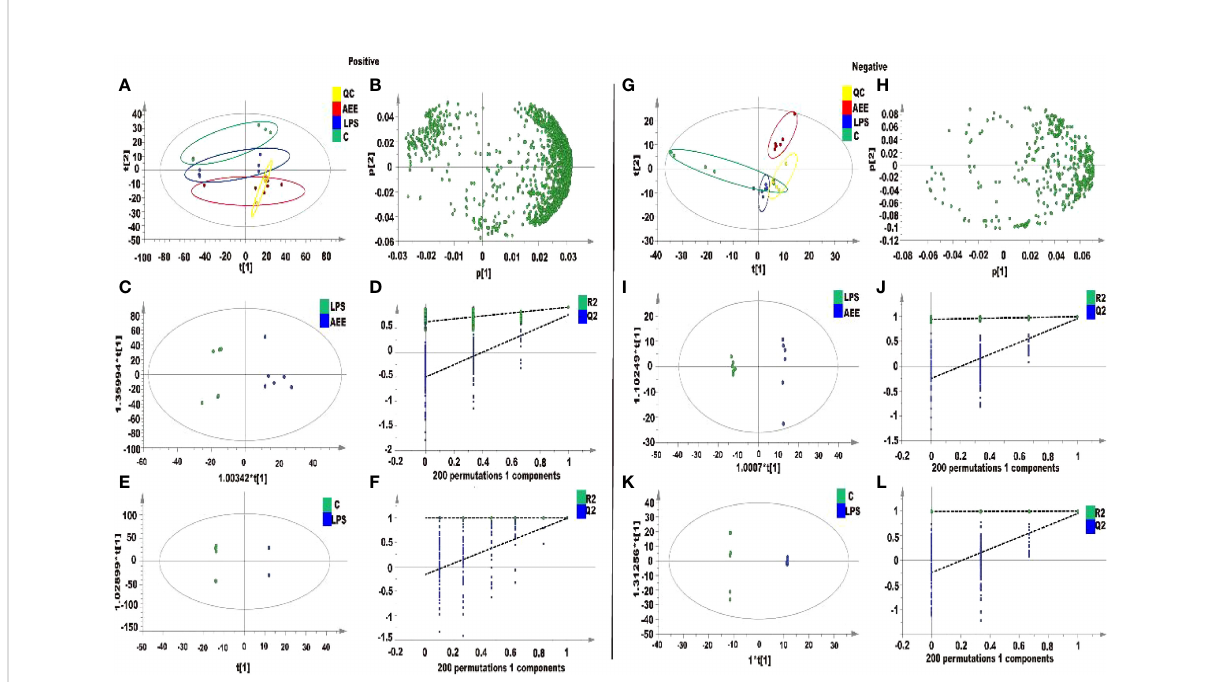
FIGURE 9 Metabolomic analysis of the effect of AEE on LPS-induced ALI in rats. (A, G) PCA score plots based on rat sera obtained from control, LPS and AEE groups in positive and negative modes, ESI+: R 2 = 0.878, ESI-: R 2 = 0.829. (B, H) The loading plots of AEE and LPS groups in positive and negative modes. (C, I) OPLS-DA score plots for AEE and LPS groups in positive and negative models, ESI+: R 2 X = 0.807, R 2 Y = 0.926, Q 2 = 0.768; ESI-: R 2 X = 0.646, R 2 Y = 0.998, Q 2 = 0.958. (D, J) Permutation test for the OPLS-DA model, ESI+: intercepts of R 2 = 0.626 and Q 2 = -0.502 and ESI-: intercepts of R 2 = 0.946 and Q 2 = -0.245. (E, K) OPLS-DA score plots for control and LPS groups in positive and negative modes, ESI+: R 2 X = 0.977, R 2 Y = 1, Q 2 = 0.992; ESI-: R 2 X = 0.887, R 2 Y = 1, Q 2 = 0.951. (F, L) Permutation test for the OPLS-DA model, ESI+: intercepts of R 2 = 0.999 and Q 2 = -0.16, ESI-: intercepts of R 2 = 0.991 and Q 2 = -0.243. Values are presented as the means ± SD where applicable ( n =